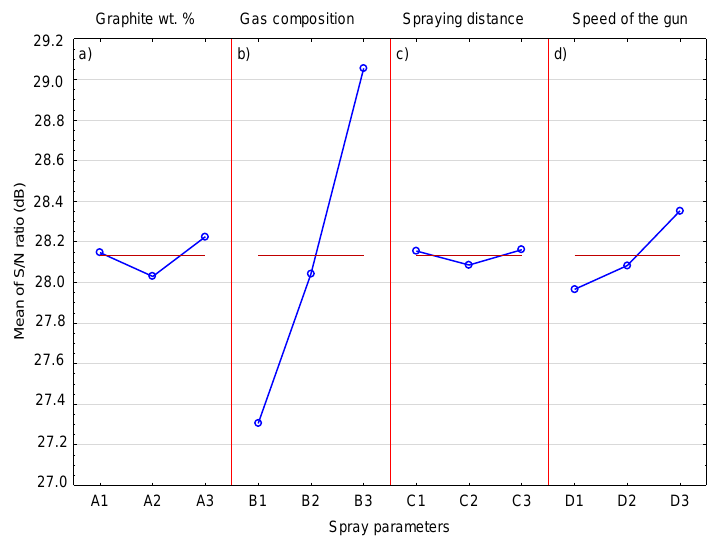
Figure 13. The mean S/N ratio for Cr 3 C 2 .